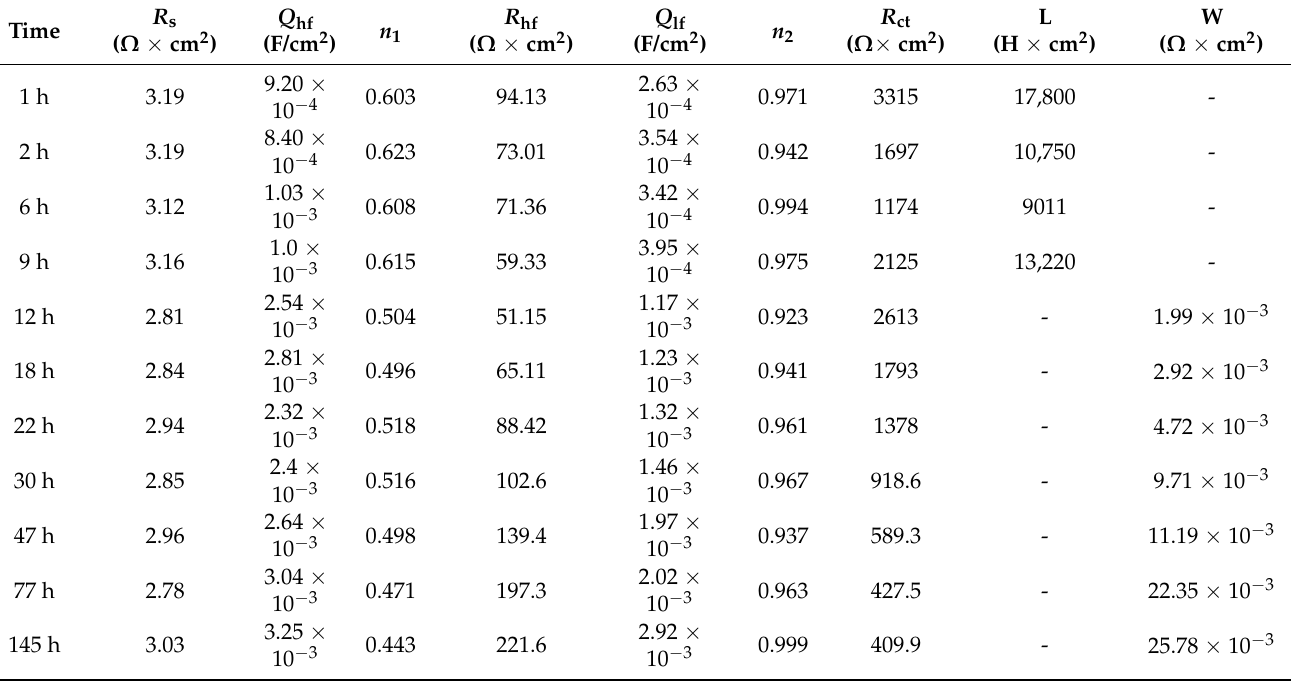
Figure 8. Equivalent circuits for Al–BN ACS with different exposure times: ( a ) Model A, ( b ) Model B. Table 1. The fitting results of the EIS parameters obtained on the Al–BN coating